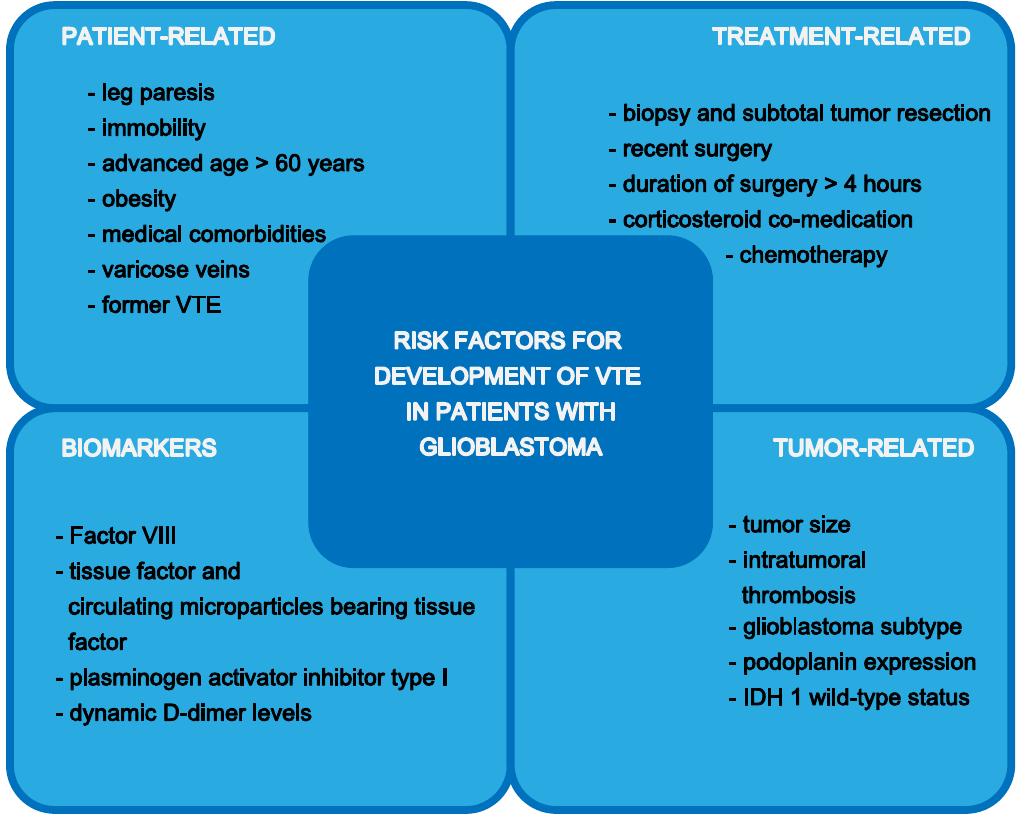
Figure 1. Risk factors for development of venous thromboembolism (VTE) in patients with glioblastoma .